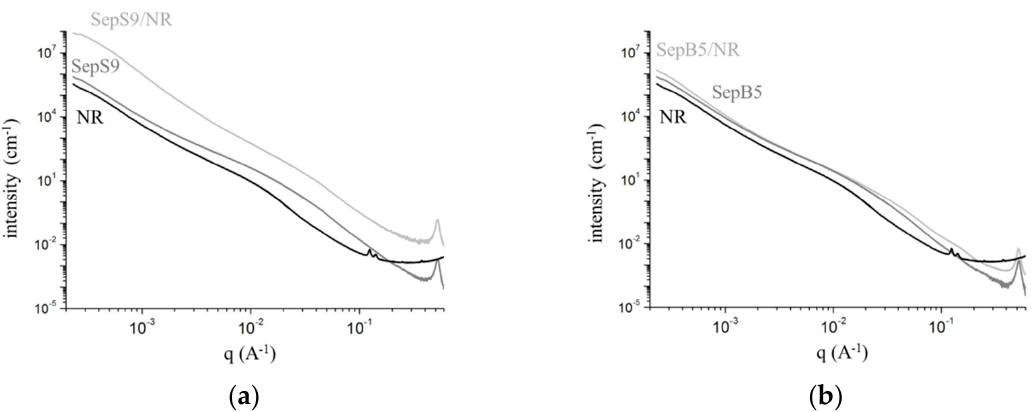
Figure 6. Scattering curves of ( a ) NR (black line), SepS9 (dark gray), SepS9/NR biocomposite (light gray), ( b ) NR (black line), SepB5 (dark gray), SepB5/NR biocomposite (light gray).